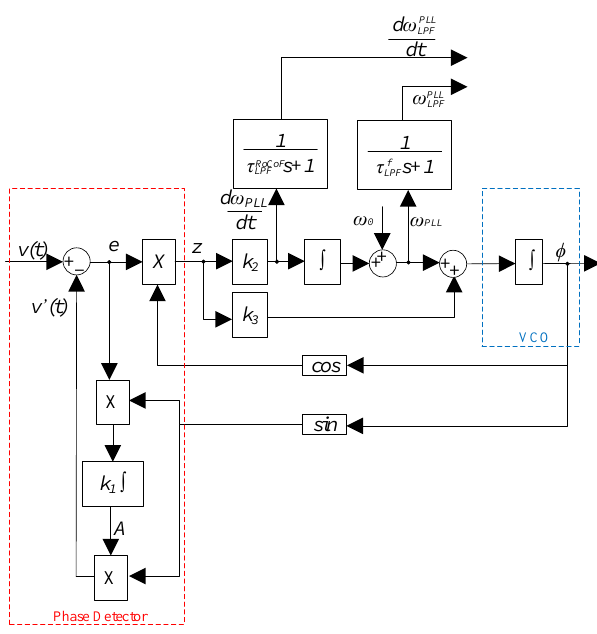
Figure 3. Single-phase enhanced phase-locked loop (EPLL) system with a direct estimation of amplitude, phase, frequency, and the rate of change of frequency